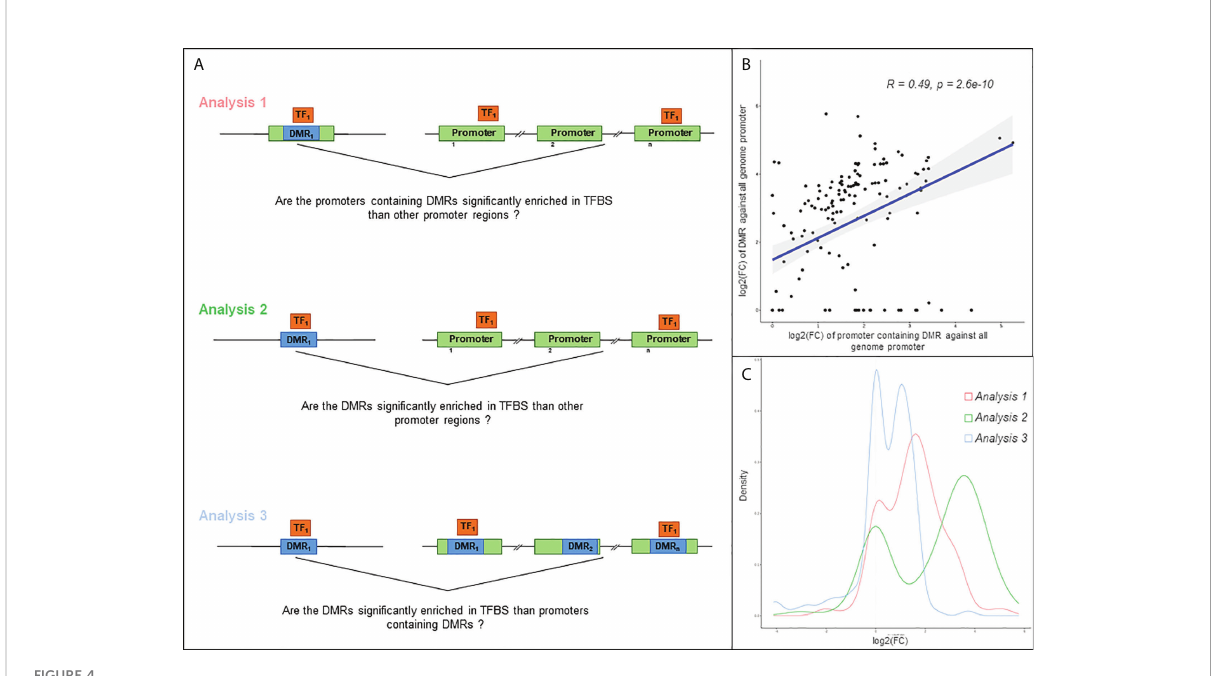
FIGURE 4 Analysis of the relation between TFBS (Transcription Factor Binding Site). (A) Schematic illustration of the three approaches used in this analysis. Differentially methylated region (DMR) is highlighted in blue, gene regulatory region in green, and transcription factor (TF) in orange. Analysis 1: TFBS enrichment in regulatory region containing at least one DMR, compared to all genome regulatory region. For each gene, a regulatory region is de fi ned as the region from TSS-1500 to fi rst exon. Analysis 2: TFBS enrichment in DMR compared to all genome regulatory region. Analysis 3: TFBS enrichment in DMR compared to regulatory region containing at least one DMR. (B) Scatter plot of the log2(FC) obtained with the analysis 1 and 2 and Spearman correlation of these values. The fold change is computed according to the observed S value compared to obtained S value, S corresponding to the number of overlapping bases between TFBS and query region. (C) Distribution of the log2(FC) obtained with the 3